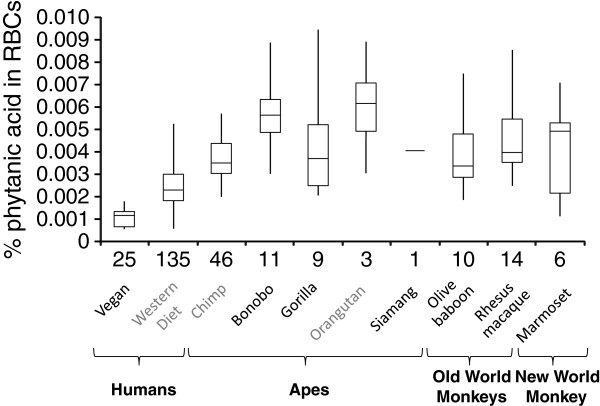
Phytanic acid levels in non-human primate (NHP) red blood cells (RBCs). Box plots representing the percentage of phytanic acid relative to total fatty acids from RBCs are provided. Median, quartile 1, quartile 3, minimum, and maximum values are provided. The number of individuals for each species is provided on the X-axes. These are annotated in black font if the information is partially (human vegan, bonobo, and gorilla) or completely (olive baboon, rhesus macaque, common marmoset, and siamang) newly generated for this manuscript (Additional file 2). The data annotated in gray font was previous reported by ourselves using the same methods [3]. Combined data from males and females are used in this analysis.